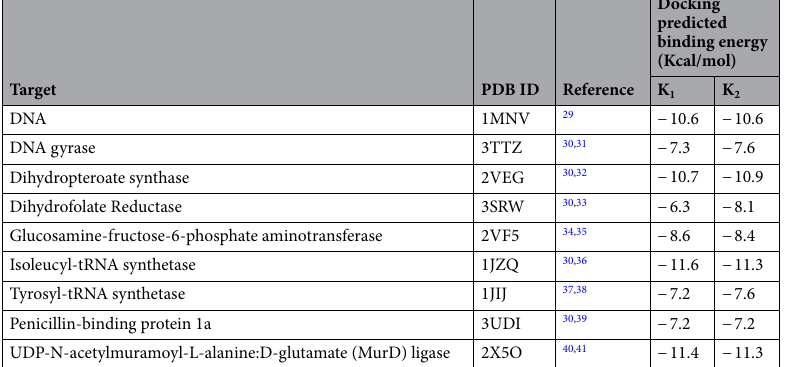
Docking predicted binding energy (Kcal/mol) K 1